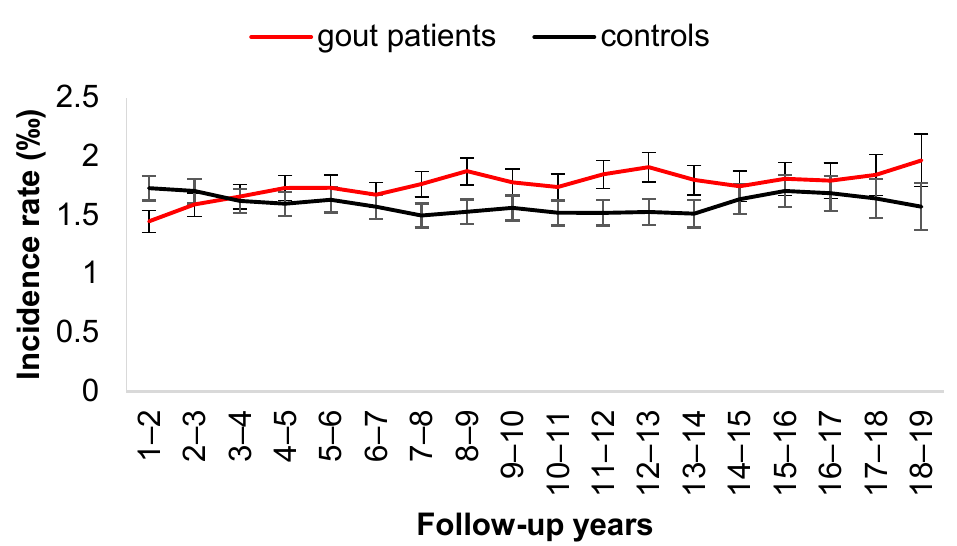
Figure 3. Two-year moving average of incident rate of hemorrhagic stroke.